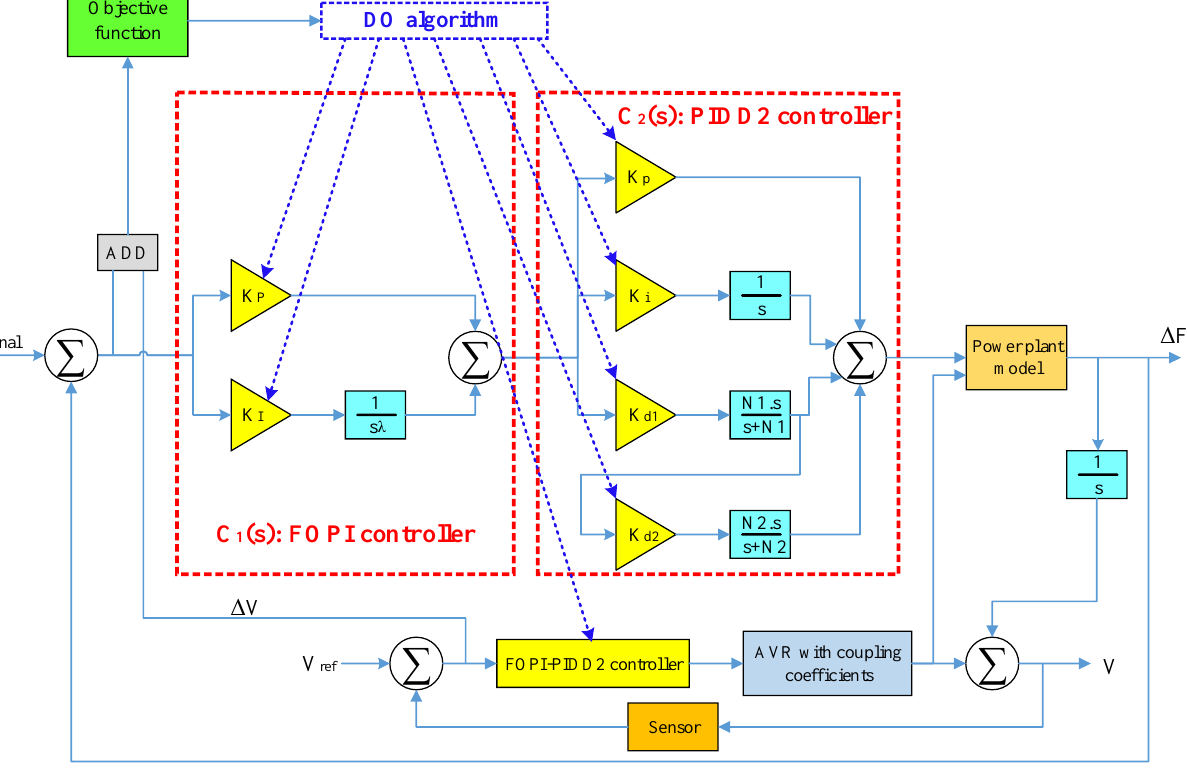
Figure 9. Structure of the proposed FOPI–PIDD 2 controller.